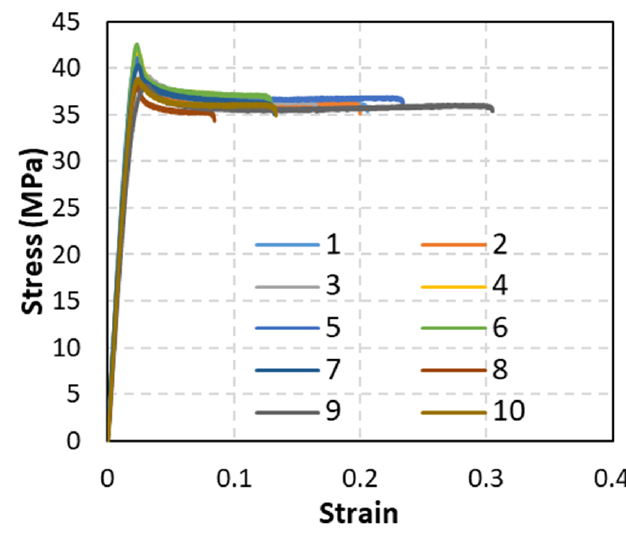
Figure 9. Stress-strain curves of PLA filaments (not reinforced).